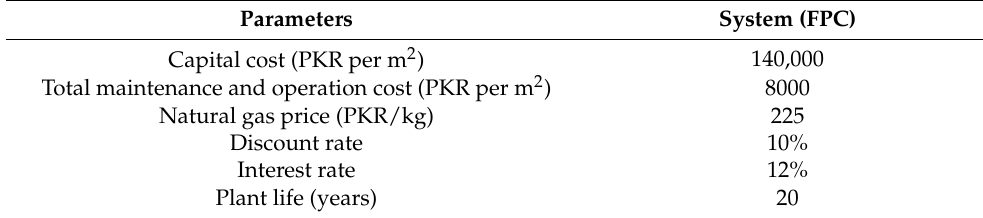
Table 2. Parameters selected for economic analysis